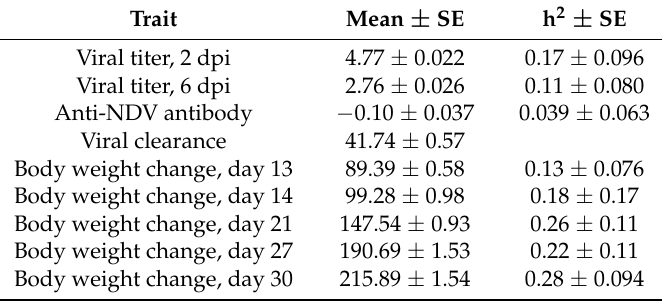
Figure 1. Viral titer, viral clearance, and anti-NDV antibody quantification of Hy-Line Brown birds by days post infection (dpi). ( A ) Log 10 viral titer distribution at 2 dpi and ( B ) Log 10 viral titer distribution at 6 dpi. ( C ) Viral clearance rate measured as the percent change in viral titer from 2 to 6 dpi. ( D ) Anti-NDV antibody measured using ELISA and depicted as the log 10 of the least-square mean of the S/P ratio at 10 dpi. NDV: Newcastle disease virus. Table 1. Trait means and estimates of heritability with standard errors in the heat-stressed and NDV infected Hy-Line Brown population.